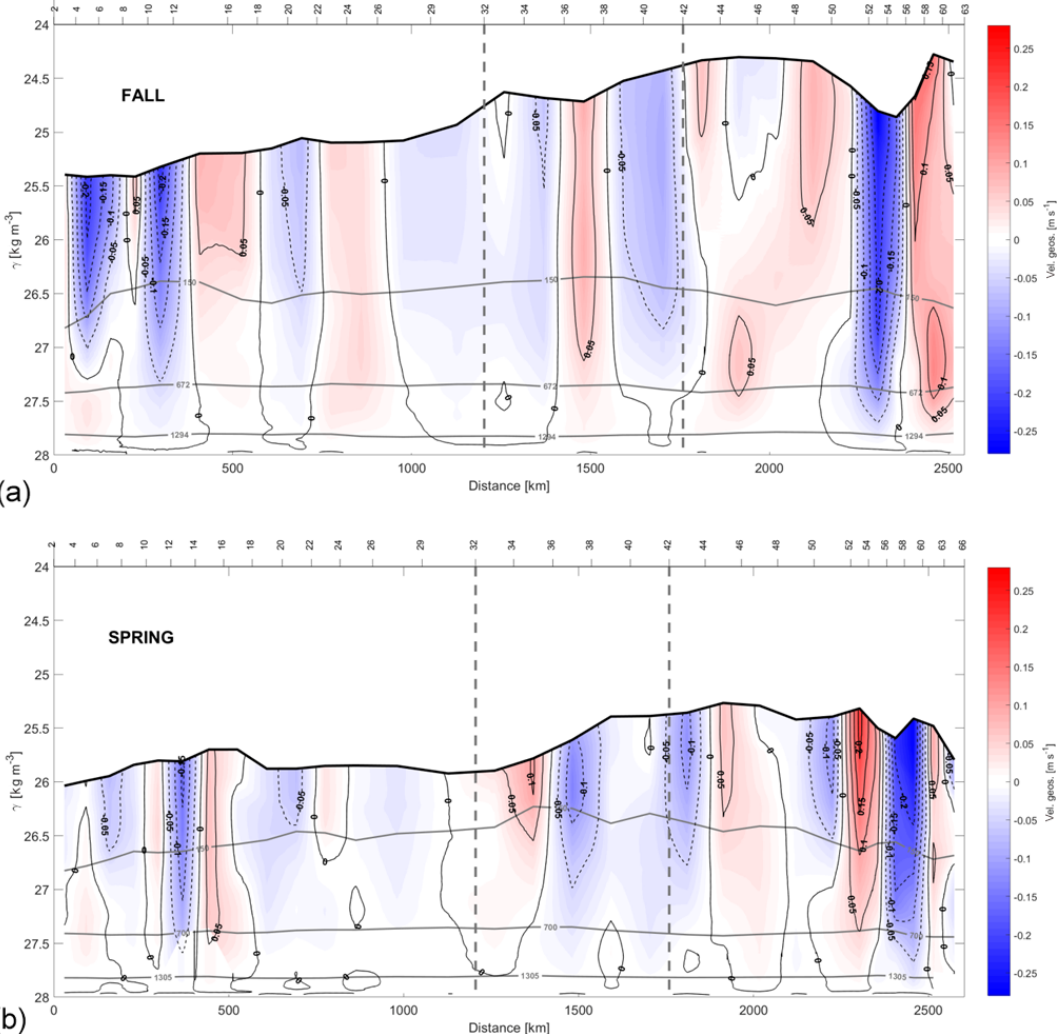
Figure 10. Sections of the absolute geostrophic velocity with respect to γ n during fall (a) and spring (b) . The horizontal axis has the same direction as Fig. 2, and the criterion of the velocity signs is as in Fig. 9. The depths 150, 672–700 and 1294–1305m are highlighted by grey isolines as in the γ n sections in Figs. 4 and